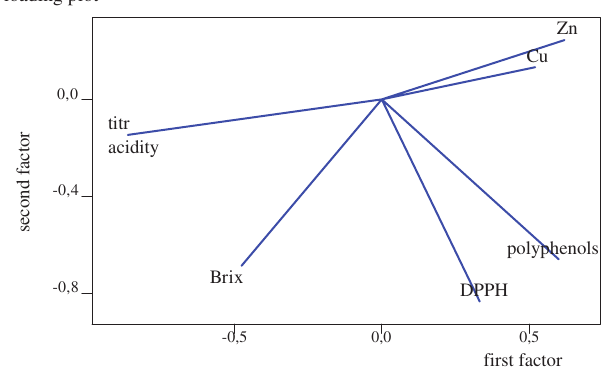
Figure 1. Principal component analysis, loading plot of apple data